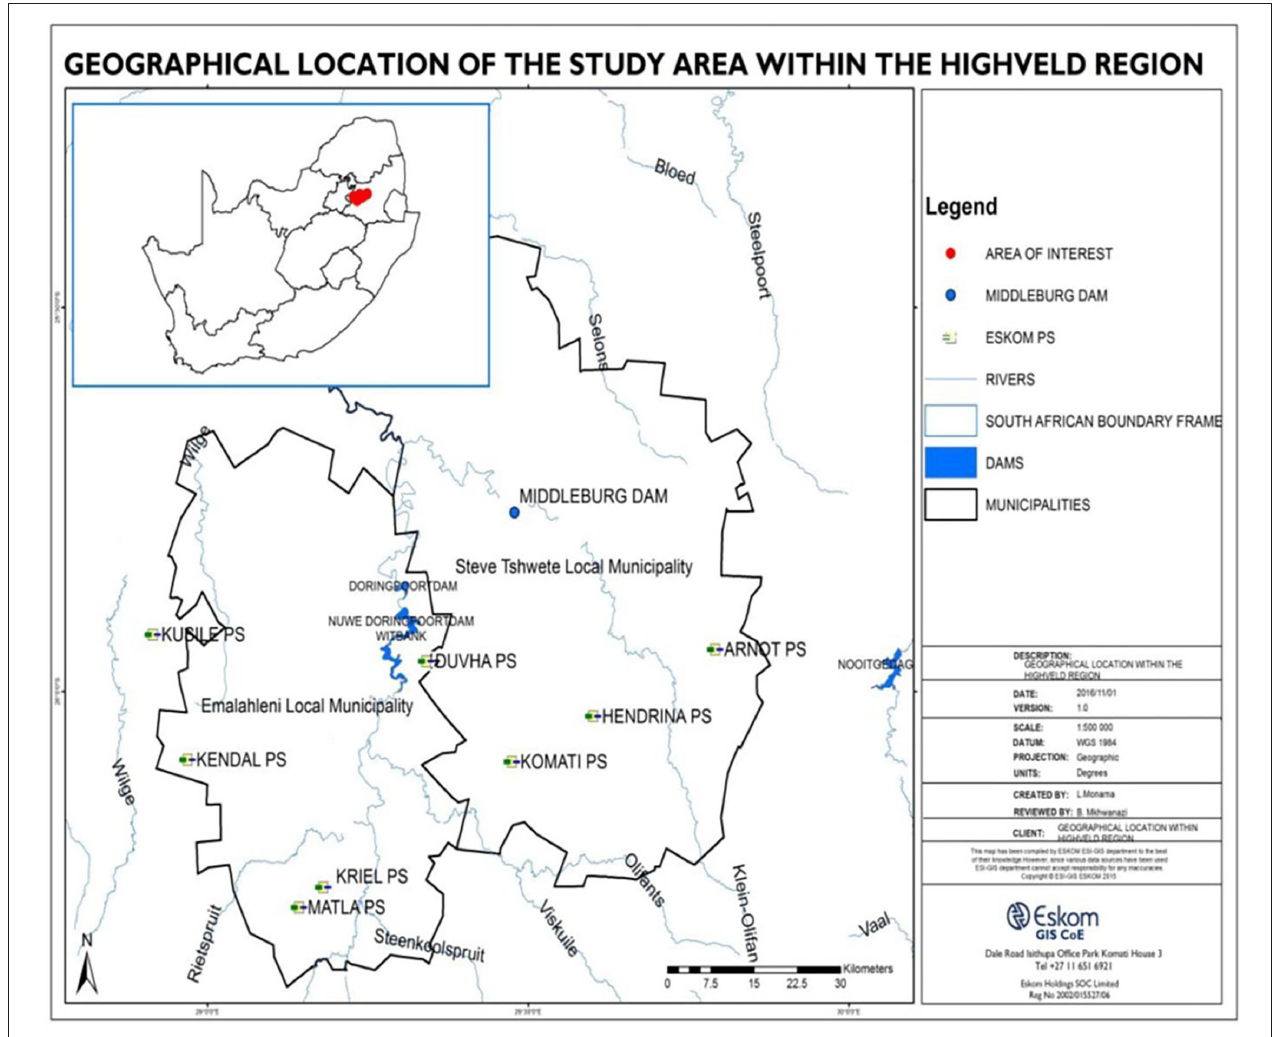
FIGURE 1 | Geographical location of the Power Stations at Highveld region, South Africa. Data Source: Eskom